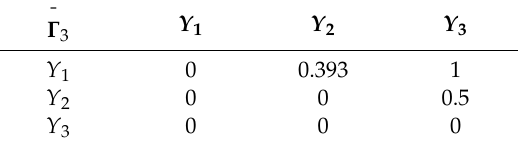
Table 15. The normalized rejoice matrix Γ 3 .